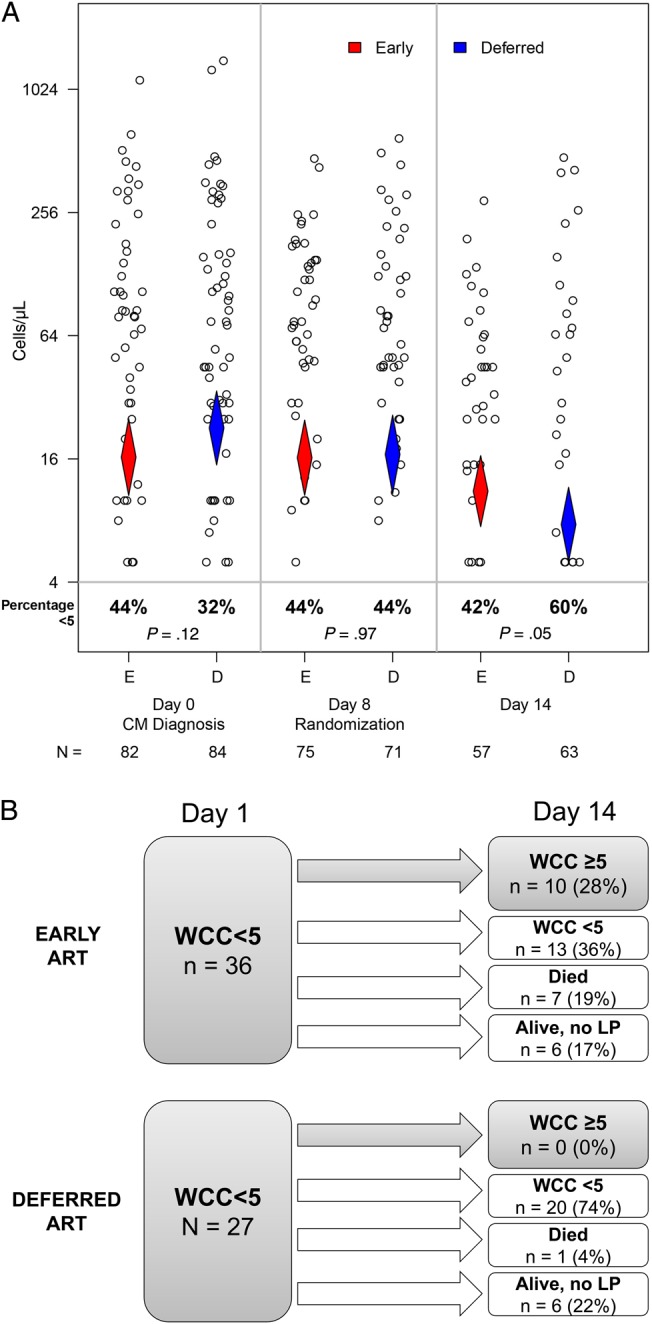
A, Differences in cerebrospinal fluid (CSF) white cell count (WCC) between trial arms during the 14 days of amphotericin therapy. WCCs are shown as dots, diamonds indicate the geometric mean and 95% confidence interval (CI), the percentage of participants with WCC <5 are shown below along with total numbers. There were no significant differences in geometric mean CSF WCC between early antiretroviral therapy (ART) and deferred ART. However, at the end of antifungal induction therapy (amphotericin day 14), the percentage of participants with CSF WCC <5 cells/µL was significantly lower in the early ART (42%) compared with the deferred ART group (60%; χ2 test, P = .047). B, Effect of early ART initiation on CSF WCC after antifungal induction therapy in participants with CSF WCC <5/µL at cryptococcal meningitis (CM) diagnosis. A similar number of participants in each trial arm had CSF WCC <5/µL at presentation (left). However, a significantly increased proportion of participants in the early ART group had WCC ≥5/µL at day 14 (top right) compared to deferred ART (bottom right) (Fisher's exact P = .0008).